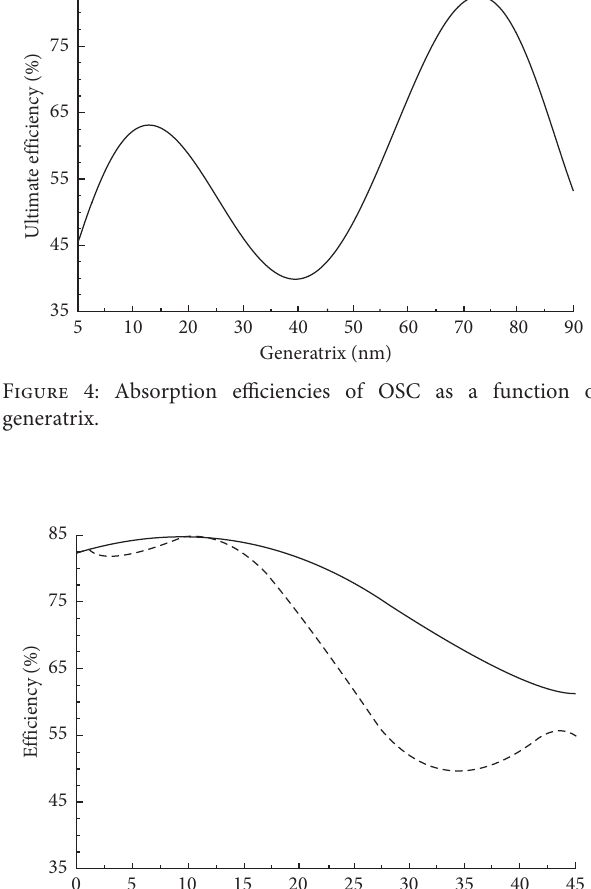
) for OSC with the Int